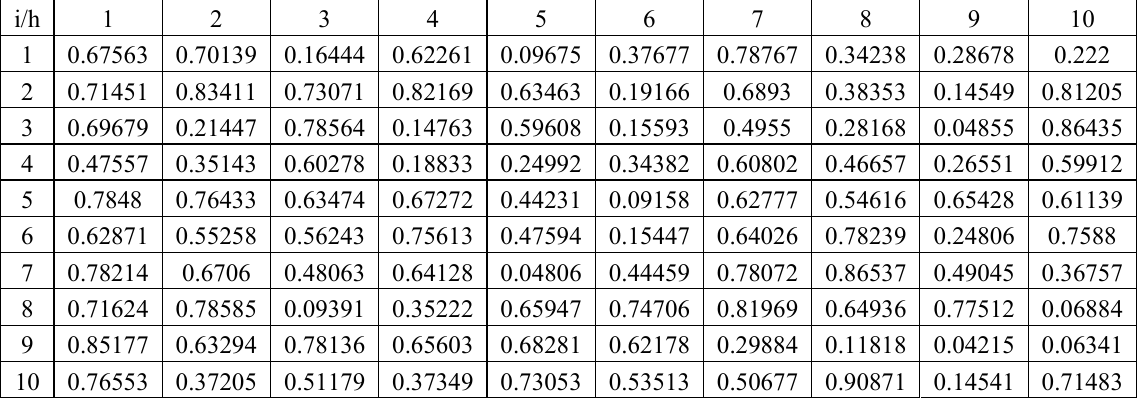
Table 3. NARXNN topology regression performance (i = nodes in the tapped delay line, h = nodes in the hidden layer).